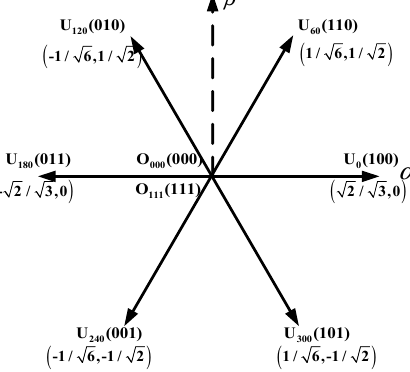
Figure 2. Voltage space vectors of a voltage source inverter (VSI).